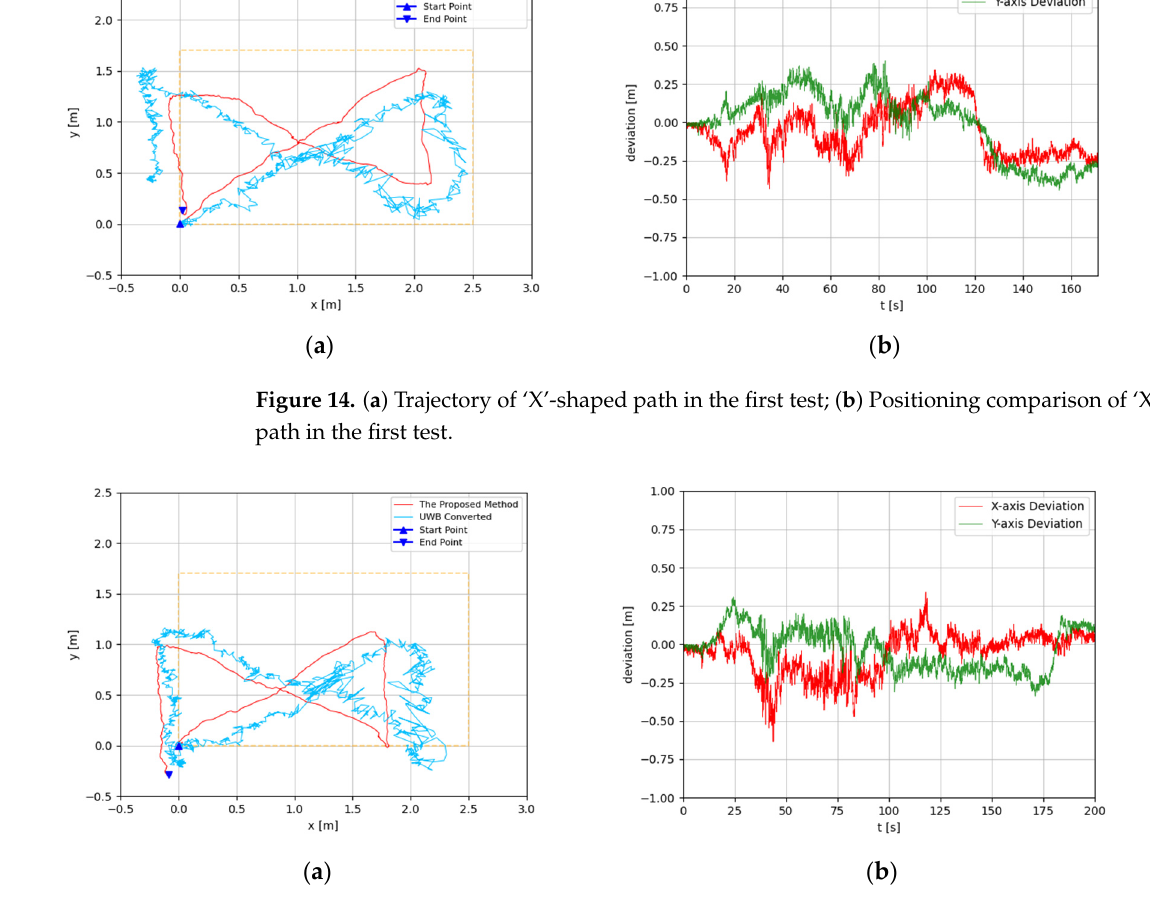
Figure 15. ( a ) Trajectory of ‘X’-shaped path in the second test; ( b ) Positioning comparison of ‘X’- shaped path in the second test.